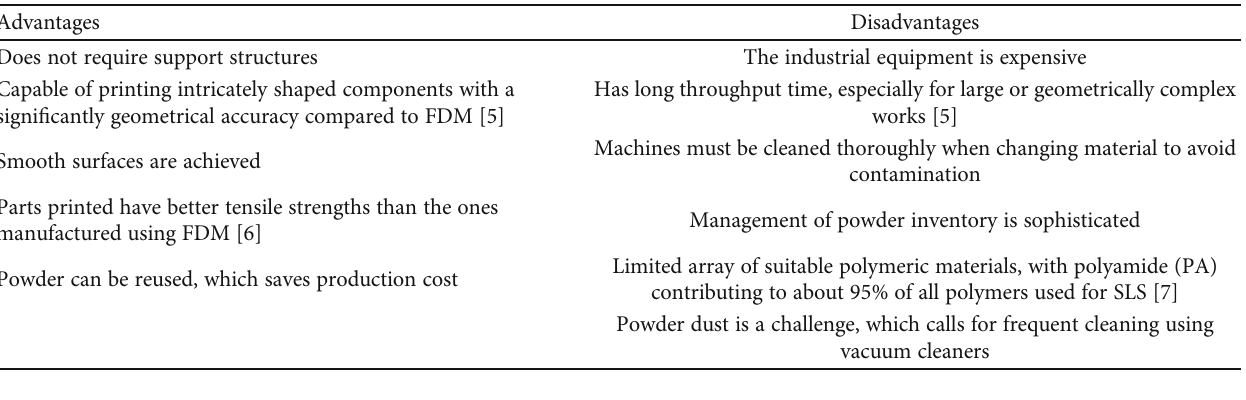
Table 3: Advantages and disadvantages of